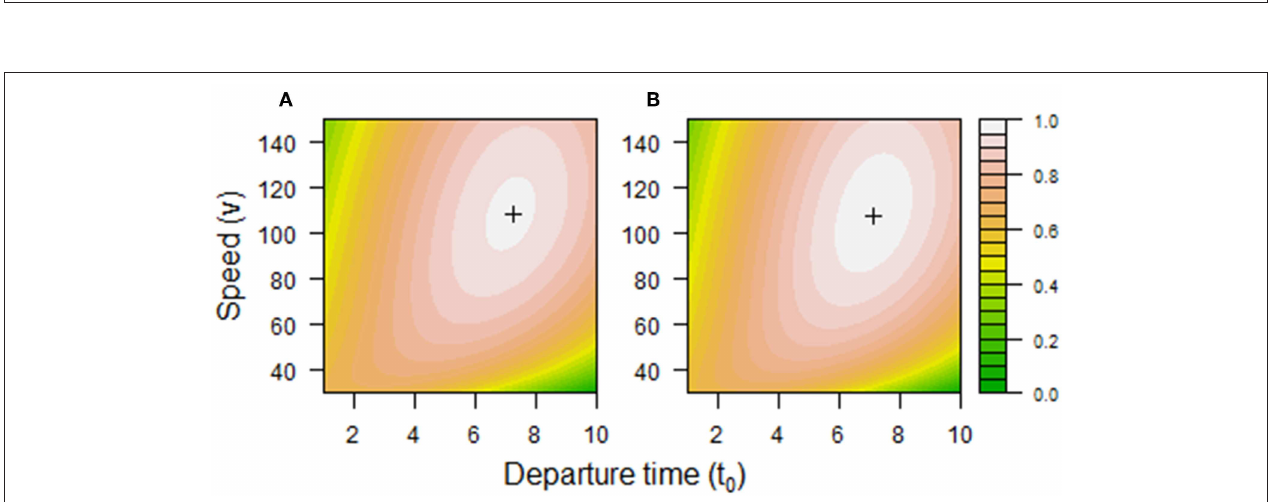
FIGURE 2 | Fitness associated with combinations of departure time ( t 0 ) and speed ( v ) using fitness component (A) S 1.1 or (B) S 1.2 and baseline parameter values in the commuting model. Optimal combinations { t 0 *, v *} are shown as crosses. In (A) t 0 * = 7.2h, v * = 109 km · h − 1 , and t 1 = 9.0h. In (B) t 0 * = 7.1h, v * = 108 km · h − 1 , and t 1 = 9.0h. The fitness contours are based on loess fits of model output with span = 0.001, with values indicated in the legend.